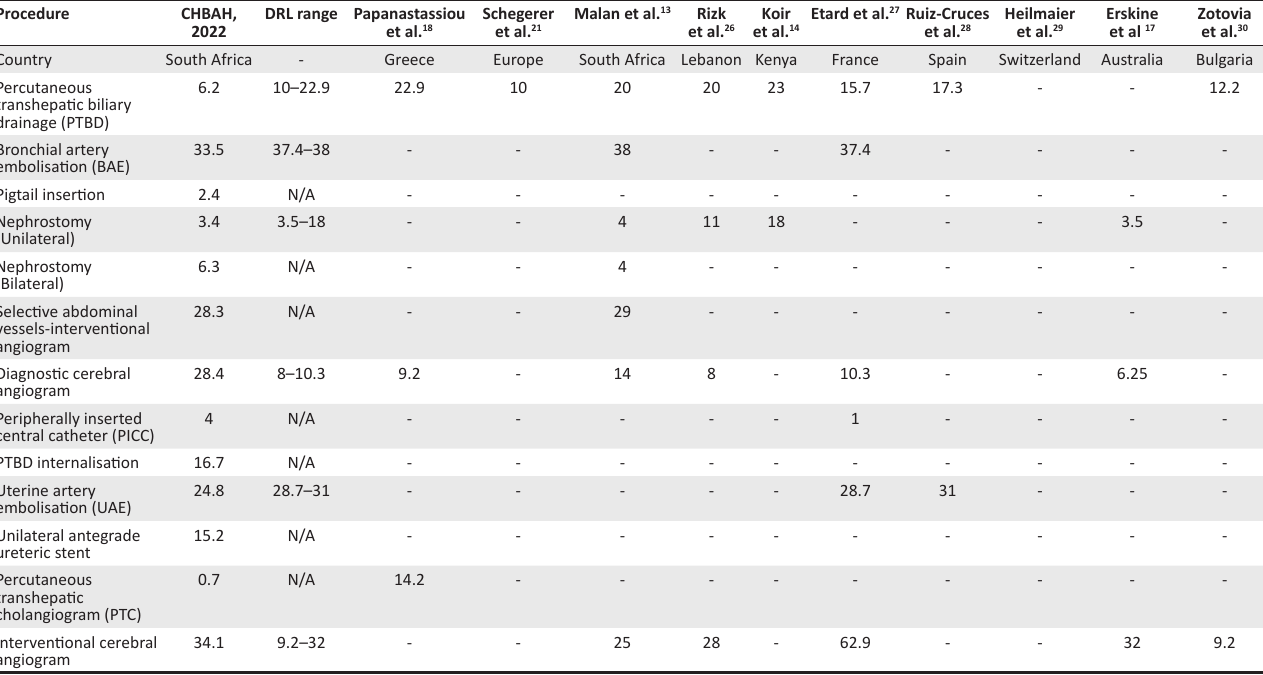
TABLE 2c: Comparison with published data on fluoroscopy time and diagnostic reference levels.